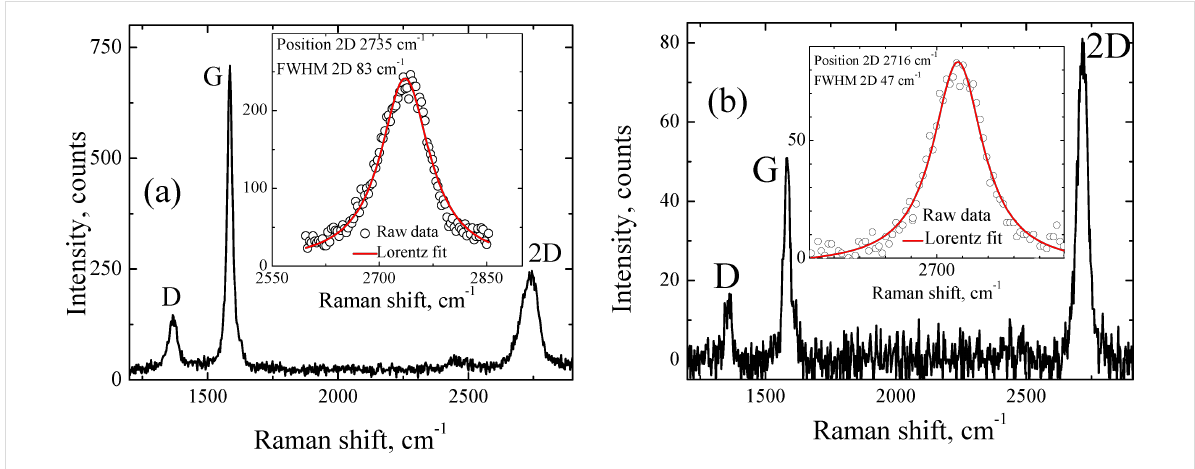
Figure 2: Raman spectrum for (a) sample A, (b) sample B on copper foil. The luminescence background from copper is subtracted. Insets: Measured 2D peak (symbols) with the Lorentz fit (line).